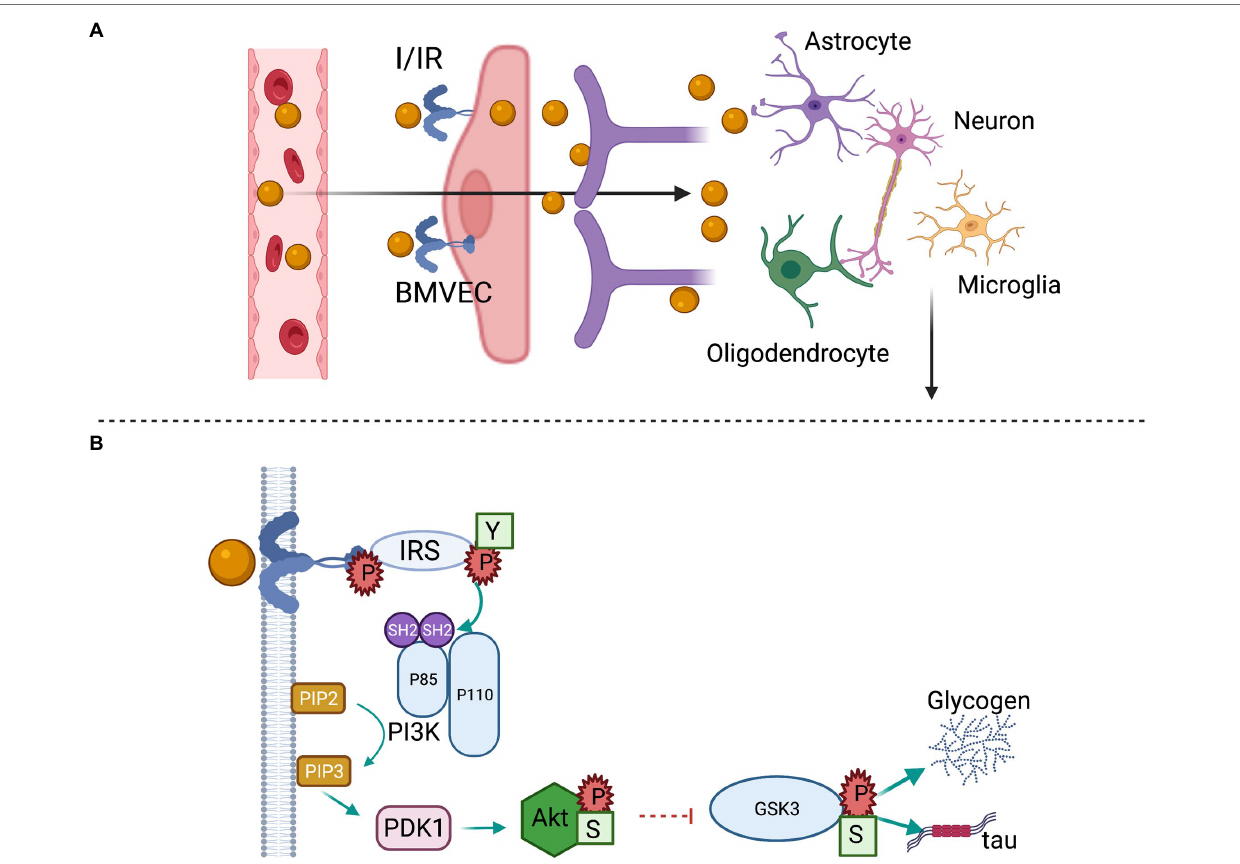
FIGURE 2 | Brain insulin transport and signaling. (A) Circulating insulin (I) binds the insulin receptor (IR) on the luminal membrane of brain microvascular endothelial cells (BMVECs). After crossing the endothelial cell layer, insulin is released at the basement membrane and may interact with pericytes, astrocytes, or act directly on neurons. (B) The activated IR has tyrosine kinase activity that initiates a cell signaling cascade. Insulin receptor substrate (IRS) proteins are phosphorylated at tyrosine residues (Y), which bind to the Src homology 2 (SH2) domains of the p85 α subunit of phosphoinositide-3 kinase (PI3K) and catalyze the formation of phosphatidylinositol-3,4,5-trisphosphate (PIP 3 ). PIP 3 catalyzes the formation of phosphoinositide-dependent kinase (PDK1), which phosphorylates and activates Akt at Serine (S) 473. The activated Akt phosphorylates and inhibits glycogen synthase kinase 3 (GSK3) β at Serine 9, stimulating glycogen synthesis and the phosphorylation of tau